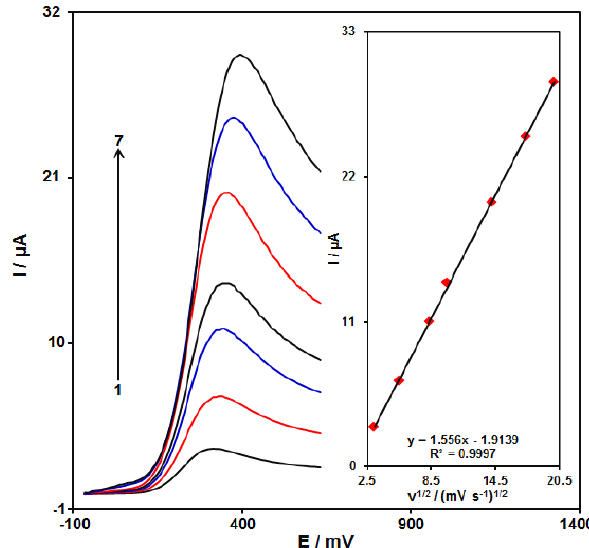
Figure 8. LSVs at the GO/ZIF-67/SPE in 0.1 M PBS at pH of 7.0 consisting of 100.0 μ M epinine at different scan rates. Numbers 1–7 correspond to 10, 30, 70, 100, 200, 300, and 400 mV s − 1 . Inset: variations in the anodic peak currents vs. ν 1/2 .